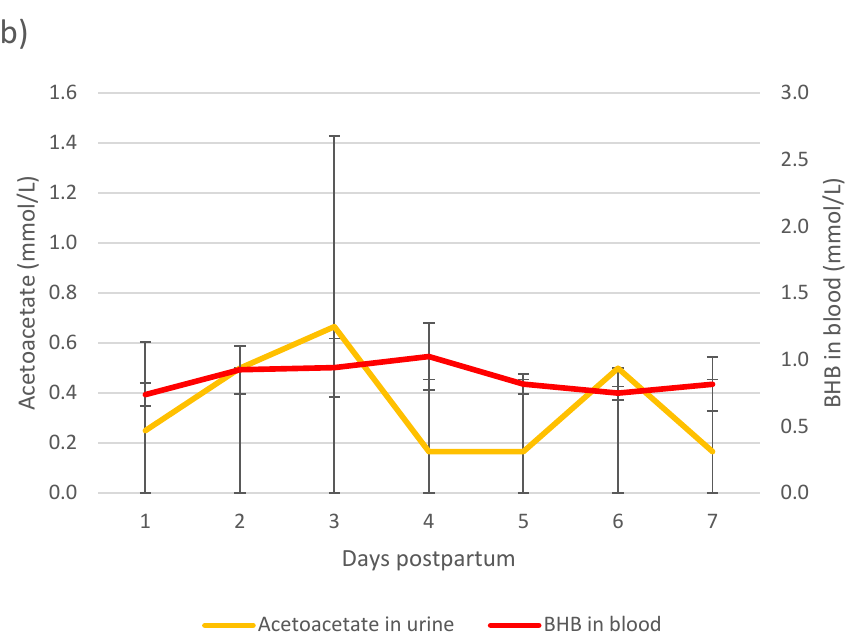
Figure 9. Concentration of BHB in blood and BHB in milk ( a ) and acetoacetate in urine ( b ) ( ± SD) for three non-ketotic cows, daily samples until seven days postpartum.